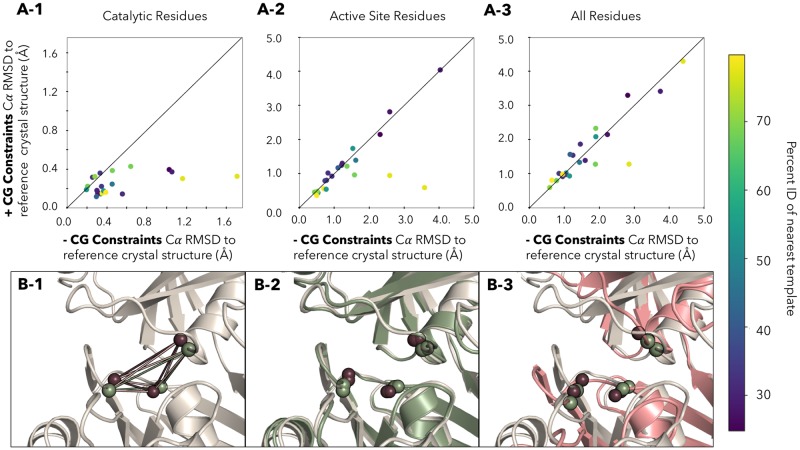
Adding CG constraints to apo models A-1 Catalytic Residues A-2 Active Site Residues (8Å), A-3 All Residues—The Y axis contains the Cα RMSD to the reference crystal structure with the CG constraints added. The X axis contains the Cα RMSD of to the reference crystal structure of the standard homology modeling. The RMSD is calculated for different sets of residues, over either just the catalytic residues, the residues predicted to be in the active site, or over the entire protein. Points below the line indicate that including the distances helps the model accuracy. Points on the line demonstrate that there was no improvement in accuracy. Targets are colored by the difficulty based on sequence homology of the closest template used for modeling. Bottom—In each cell, the Cα atoms of each catalytic residues (Cys-73, Cys-217 and Glu-208) are shown in burgundy. Each of the Cβ atoms are shown in green. B-1 Crystal structure of benchmark target 2gke (grey). Lines drawn between indicate the measurements between atoms that are used as CG constraints. B-2—With the addition of the CG constraints to the model, the catalytic residues of the CG constrained model (green) overlays with the crystal (grey). B-3—Standard homology model (red) with the Cα and Cβ atoms shown as spheres. All results in this figure are from the best of the five lowest in energy models, the equivalent figure illustrating results from the single lowest energy model with addition of CG constraints is presented in S2 Fig.